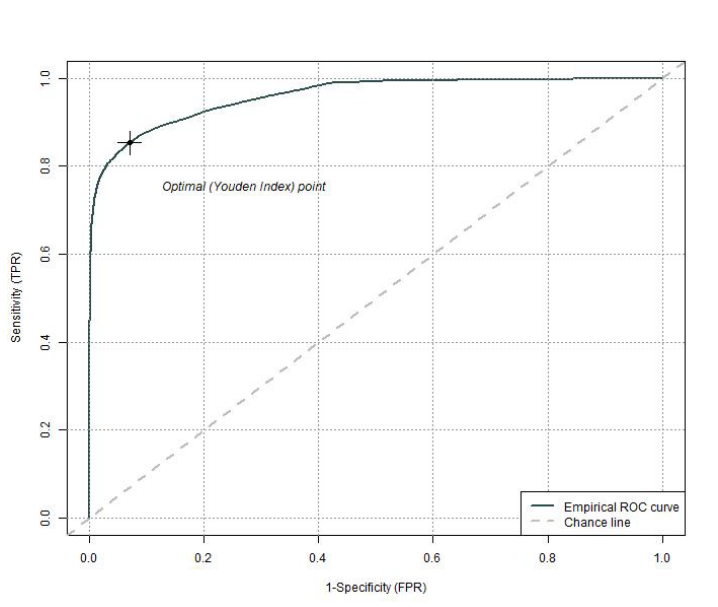
Figure 3. Exemplary receiver operating characteristic (ROC) curve for a sample size of n = 2. The Youden index which is the point of the curve that is most distant from the chance line is the average OD value that maximises the difference between TPR and FPR.